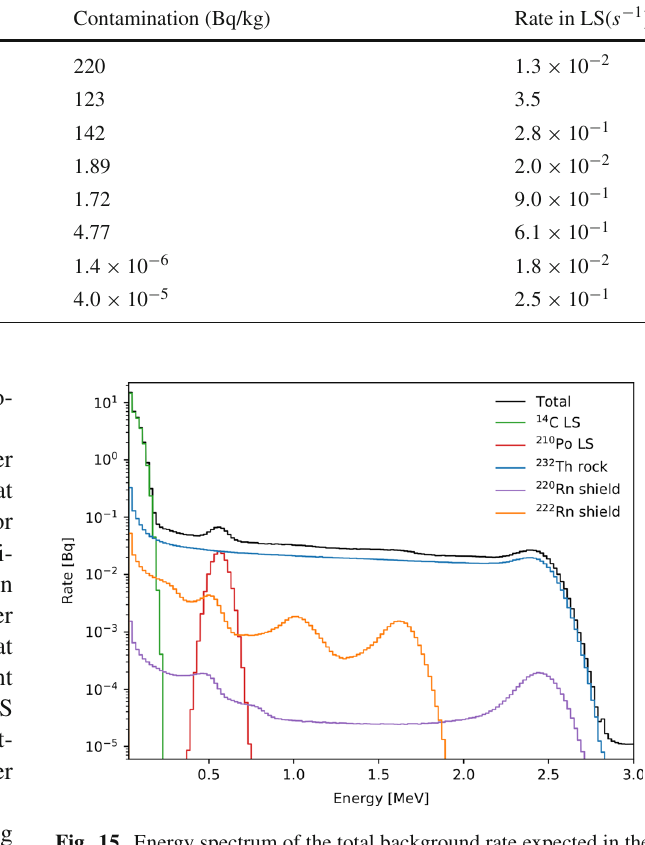
Fig. 15 Energy spectrum of the total background rate expected in the full LS volume including Radon contamination of the water shield. Only the contributions that define the shape are overlayed to show their influence in the different energy regions (based on